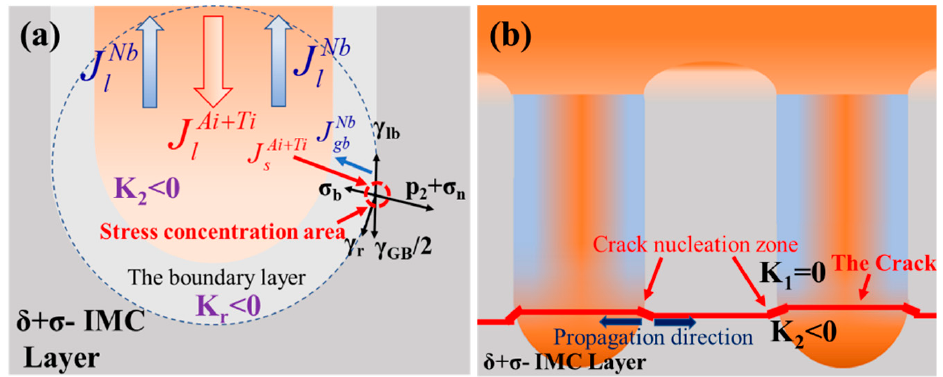
Figure 14. ( a ) Schematic illustration of the related stress interactions coupled with element diffusion, ( b ) schematic illustration of crack nucleation and propagation.